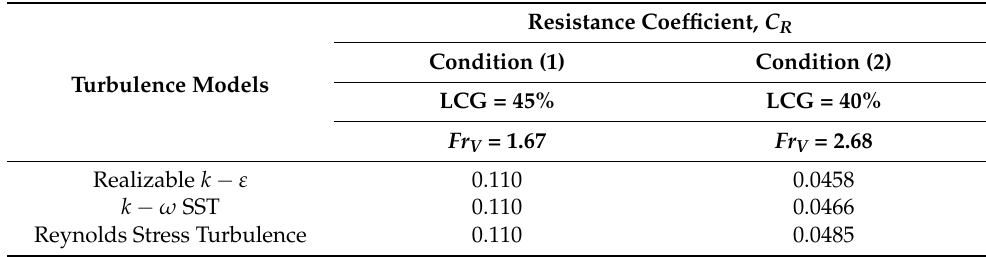
Table 2. Resistance coefficient obtained with different turbulence models at two operating conditions.